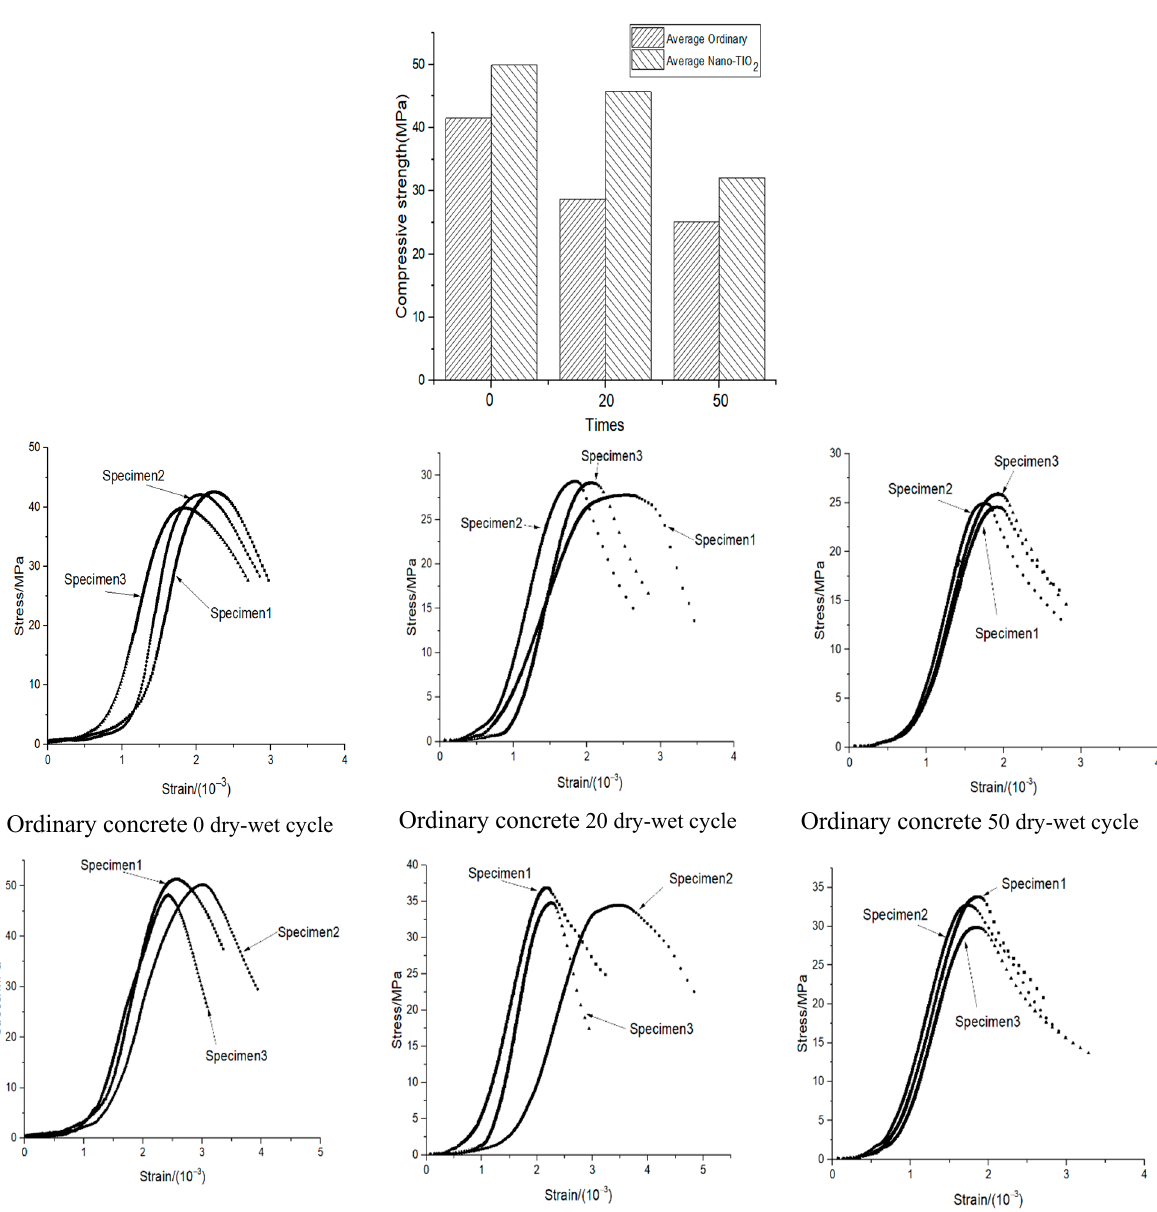
Figure 4. The influence of dry–wet cycles on the concrete compressive strength.